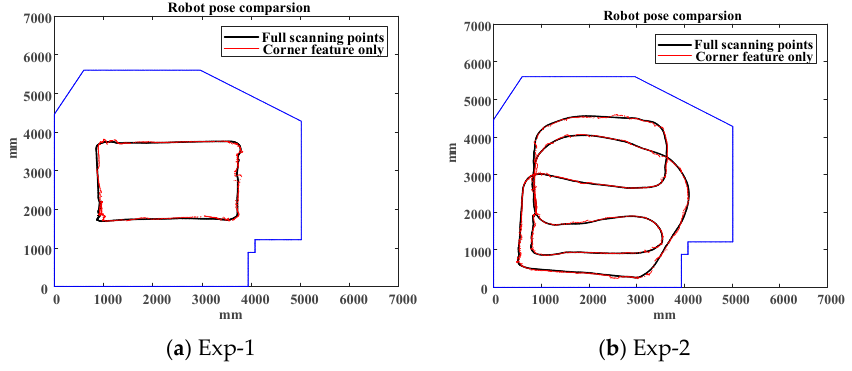
Figure 10. Different algorithms for the first/second experiments.